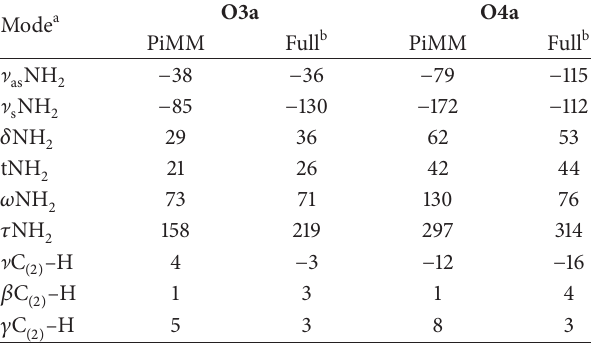
Table 3: Comparison of the B97D CP-corrected frequency shifts predicted by the PiMM and the full cluster approaches for the NH and C (2) –H related vibrational modes. Only the vibrational shifts for the O3a and O4a clusters are presented (for the other iPram clusters see Table S8 of the Supplementary